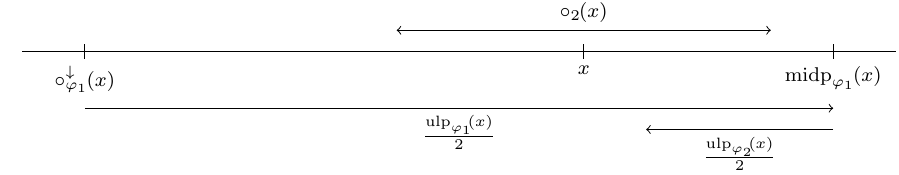
( x ) and since x is below 1 ( x ). 1